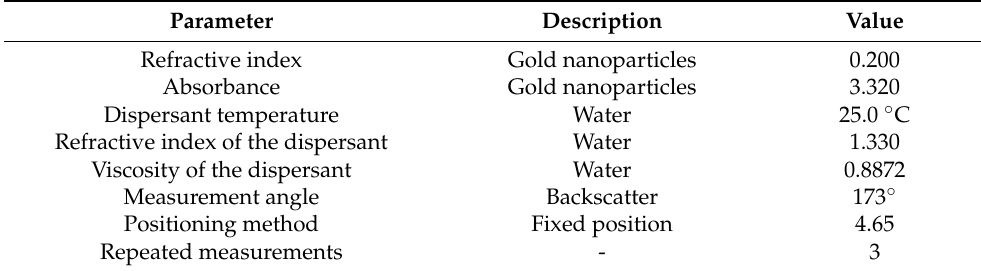
Table 1. Parameters used for the DLS